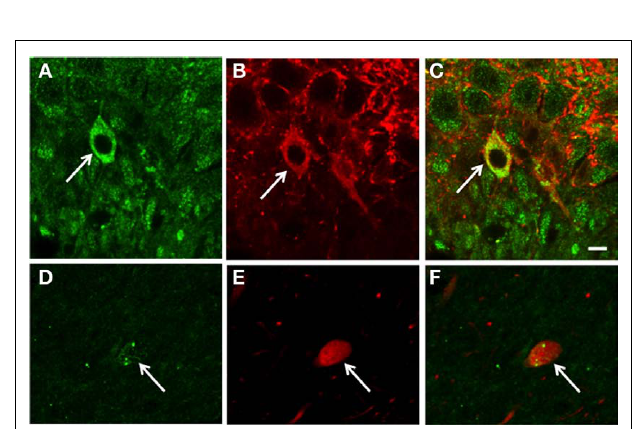
FIGURE 2 | Confocal microscopy shows that pMOR-ir is contained in some PARV-labeled interneurons. In dorsal blade of the dentate gyrus, pMOR-ir (A) and PARV-ir (B) are co-expressed a neuron be [merged image (C) ]. In the CA3, sparse pMOR-ir (D) and PARV-ir (E) are co-expressed in a neuron [merged image (F) ]. gcl, granule cell layer. Scale bar = 10 μ